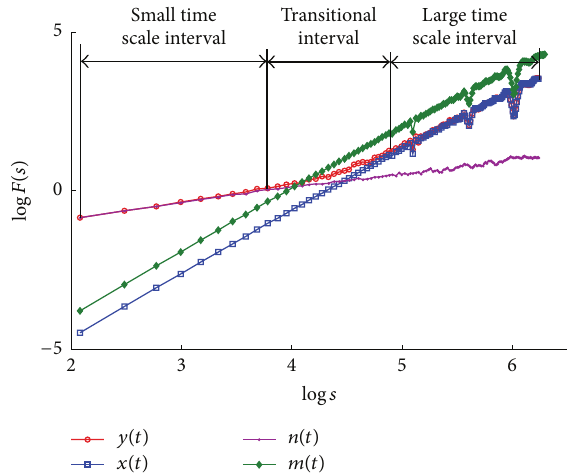
Figure 3: The experimental setup of the gearbox fault